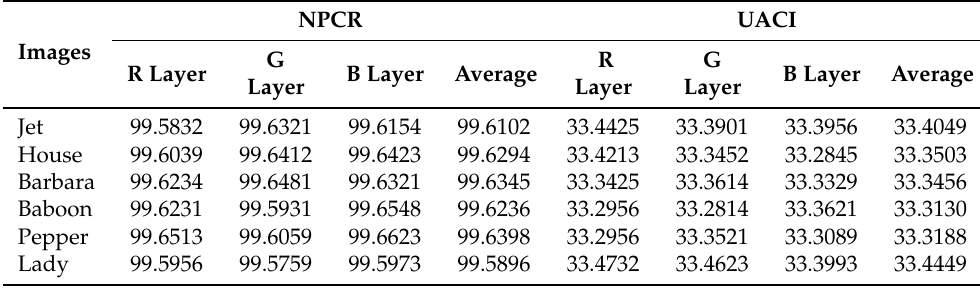
Table 5. NPCR and UACI results for the color plane the of cipher